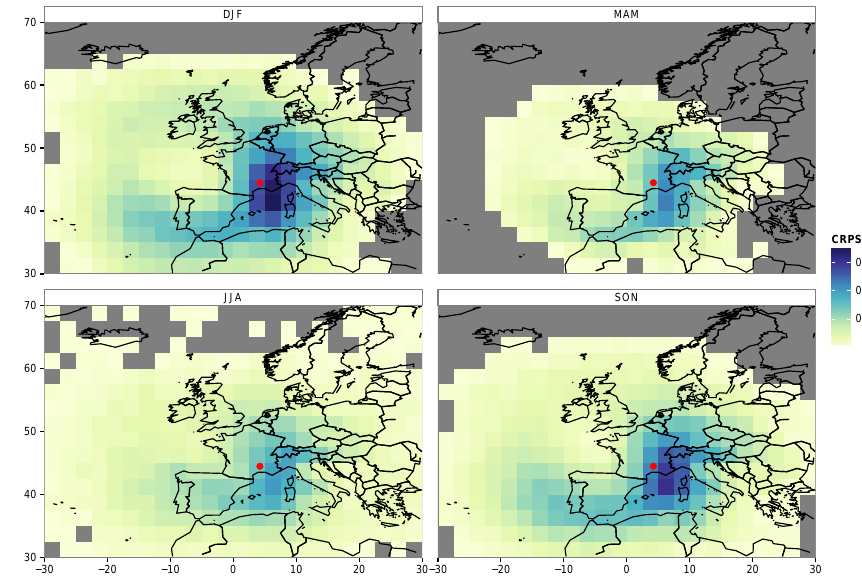
Fig. 4. Seasonal relevance maps for the Ard`eche case study zone.